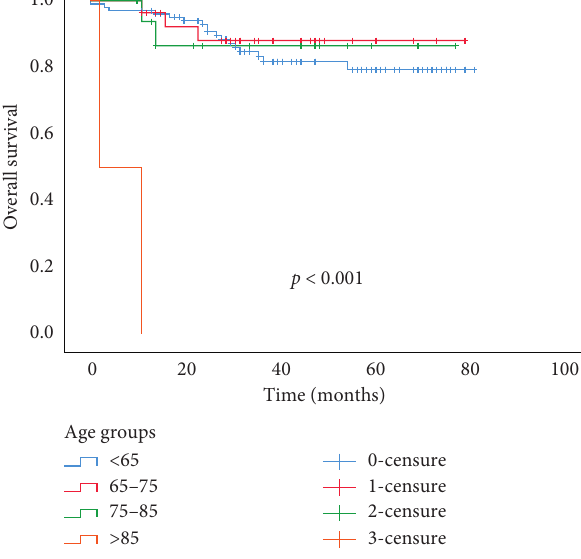
Figure 3: Kaplan–Meier curves for the duration in months of OS according to patient’s age